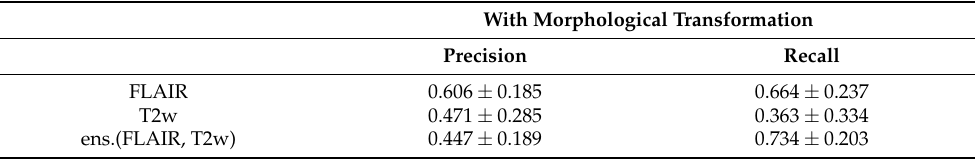
Table 7. Detection results on 62 sessions from the DIPG test dataset excluding the 9 sessions where detection step failed to detect anything. Results present the mean ± standard deviation.